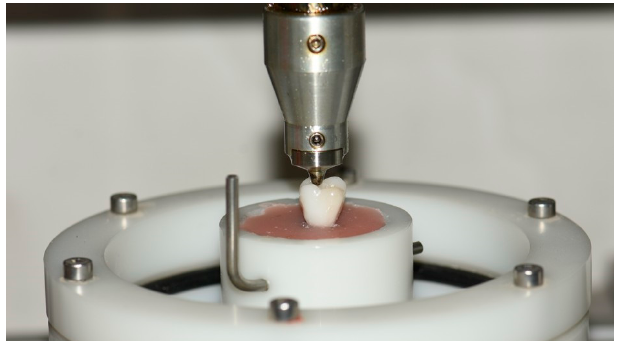
Figure 2. Dynamic loading of upper molar with masticatory simulator (CS-4, SD Mechatronik, Westerham, Germany) for fatigue testing. Embedded implant with crown in standard sample pot. Steel cone antagonist adjusted to touch the crown at the fissure.